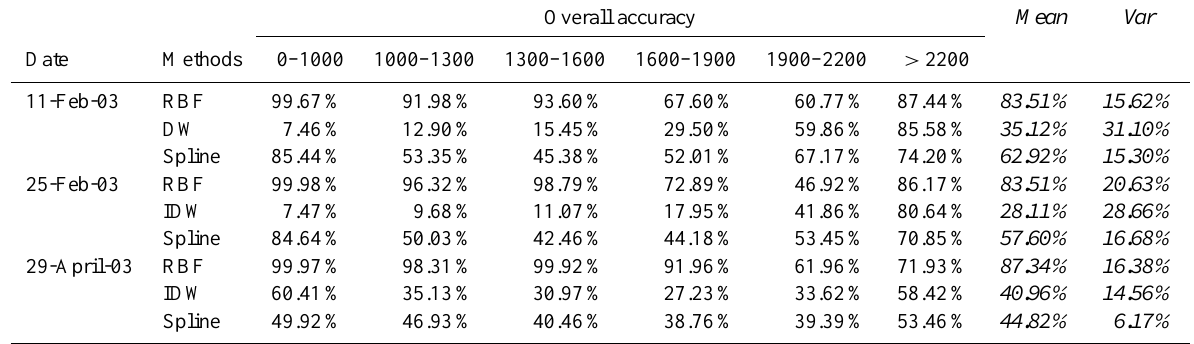
Table 13. Comparison analysis among IDW, B-Spline and RBF: the results are presented in terms of overall accuracy for 6 elevation ranges. Overall accuracy Mean